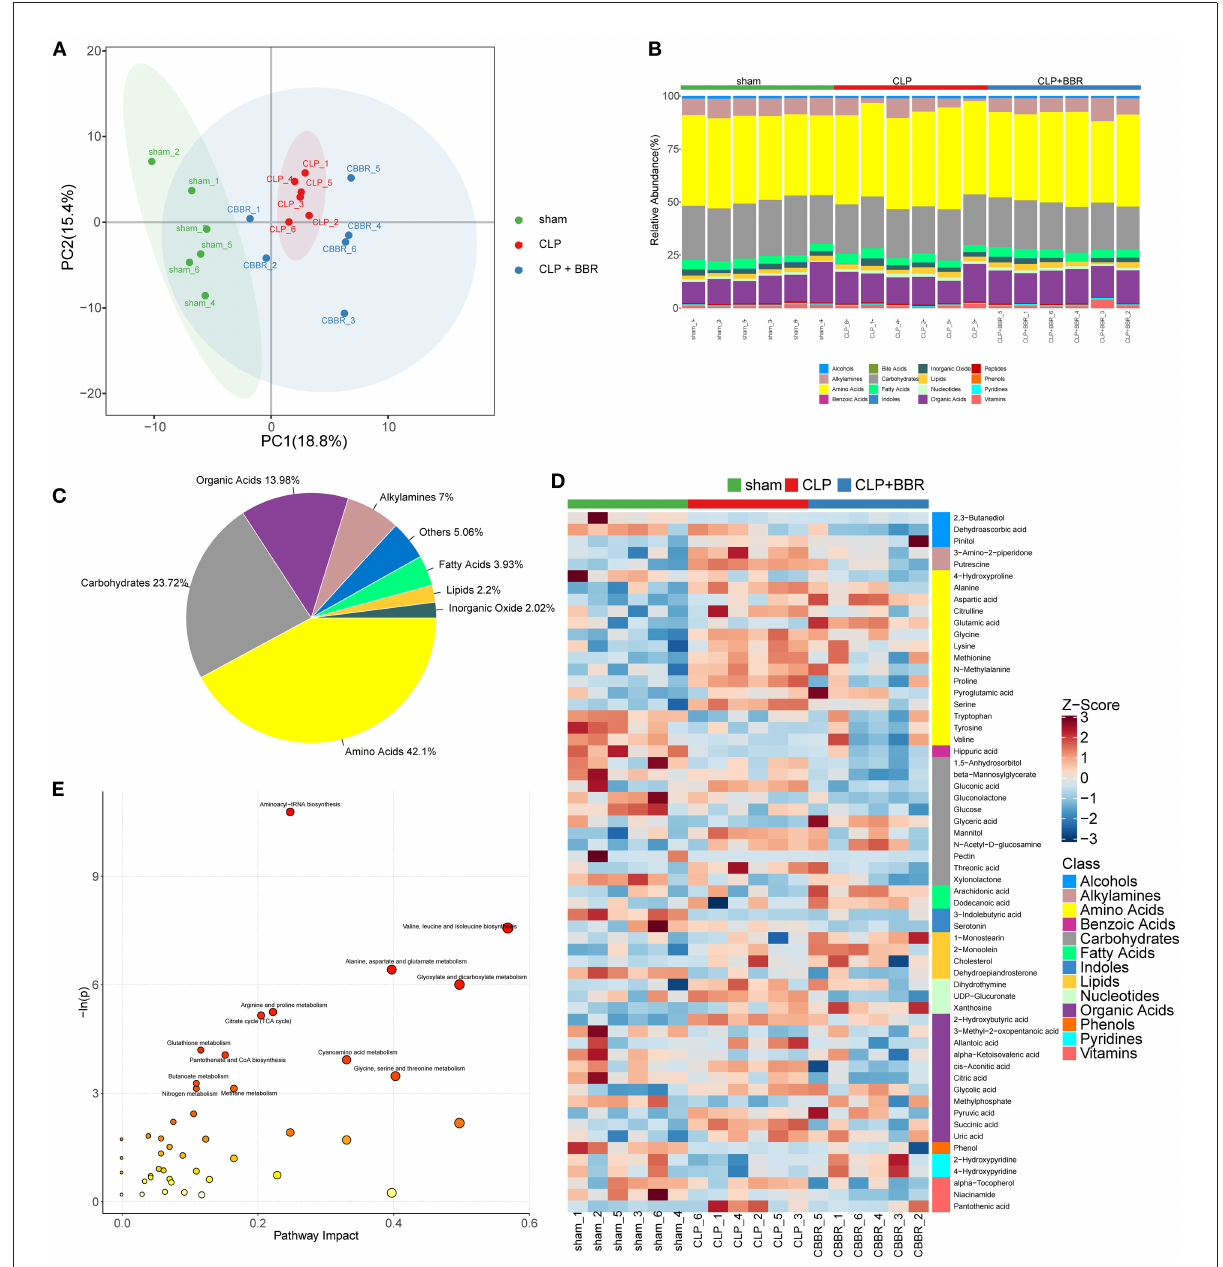
FIGURE6 Metabolomic analysis of cecal ligature and puncture (CLP) rats with berberine (BBR) treatment. (A) The principal component analysis (PCA) score plot with samples of the sham group, CLP group, and CLP + BBR group. (B) The stacked histogram of relative abundance of metabolite class in each sample. (C) The proportion of key metabolites is shown in a pie chart; (D) The heatmap of potential biomarkers with p -value < 0.05 and |log 2 (fold change)| ≥ 0. In right is the class and each class internal metabolite was ranked by the Z -score change feature. (E) The bubble plot of pathway enrichment analysis. Each circle corresponds to a metabolic pathway and the abscissa represents “pathway impact.” The bigger circle, the value of “pathway impact.” The color that changes from yellow to red is positively correlated with the negative log p -value of the pathway’s altered p